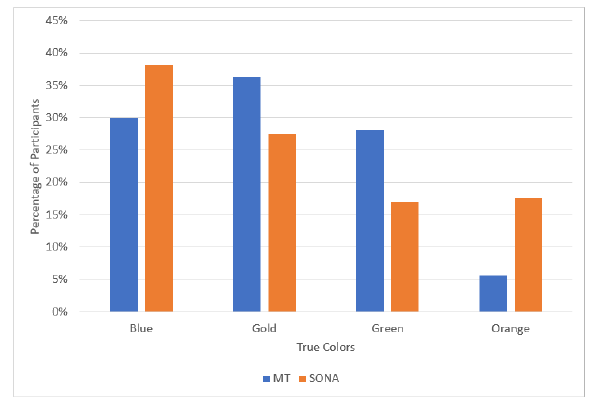
Figure 6. Participants with each True Color self-schema in MTurk (MT) vs SONA.